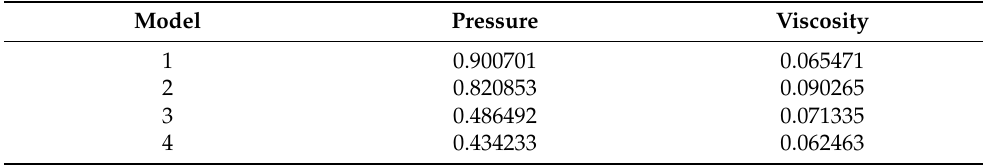
Table 8. Influence of viscosity and pressure on drag coefficient.